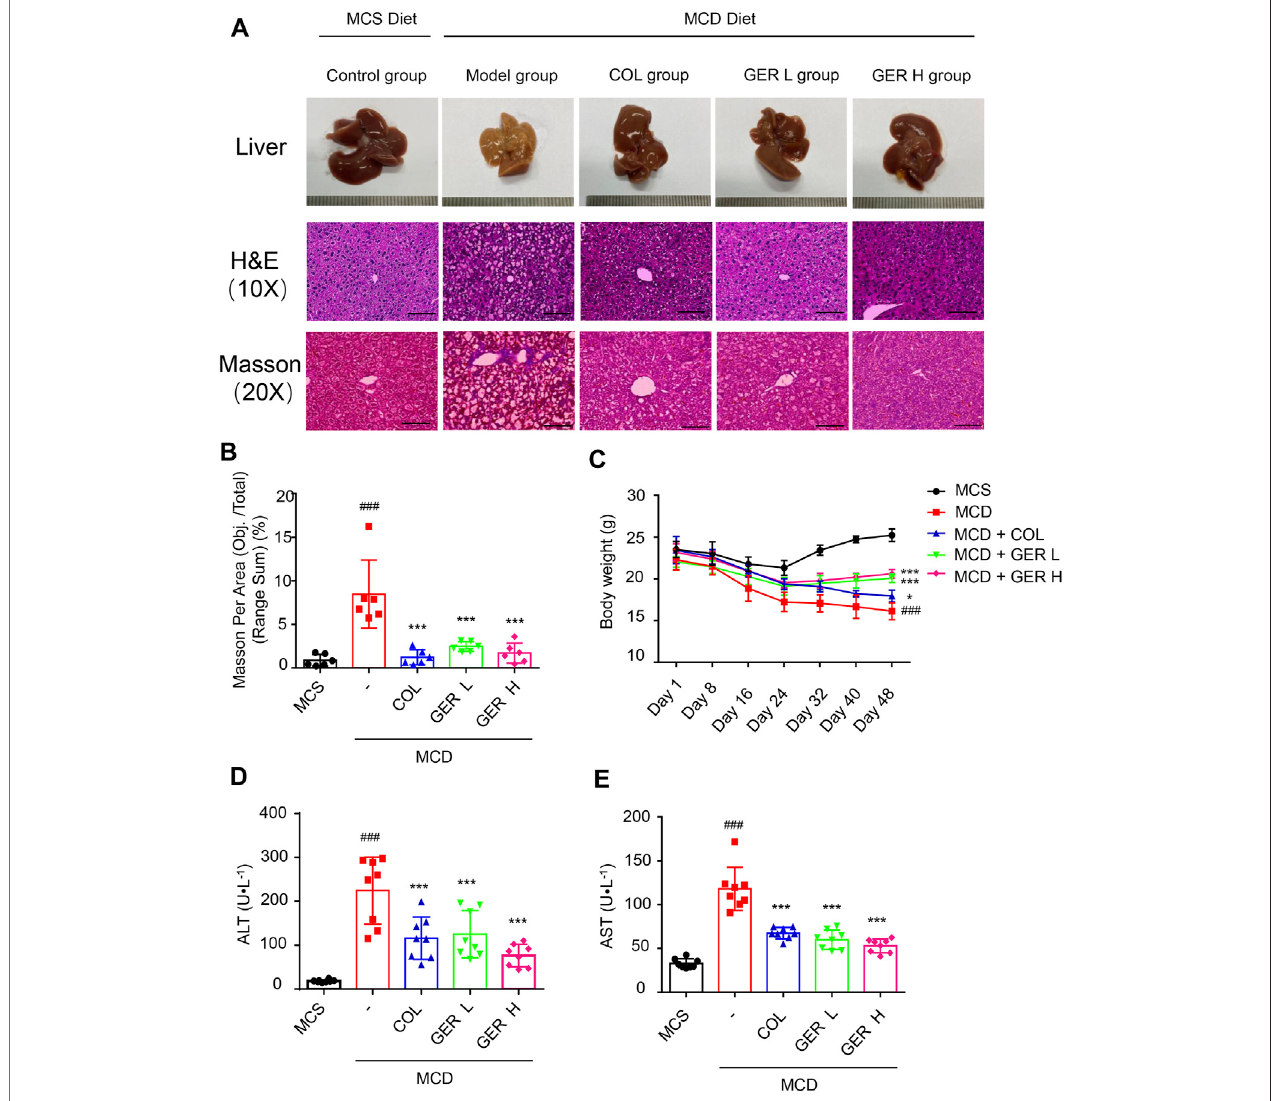
FIGURE 5 | GER ameliorates MCD diet-induced liver tissue and function damage. (A) Representative images of the liver and representative images of the liver sections stainedwithhaematoxylinandeosin(H&E, scalebars,50 μ m) andmasson(scalebars,100 μ m).Colchicine(COL)wasusedaspositivecontrol,GERL:thelow dose (25 mg/kg) of GER group, GER H: the high dose (50 mg/kg) of GER group. (B) Quanti fi cation of masson changes in different treatment groups ( n (cid:2) 6). (C) The weight changes of mice in different group for per 7 days (D,E) Serum alanine transaminase (ALT) and aspartate transaminase (AST) levels ( n (cid:2) 8). All data are presented as means ± SEM. ### p < 0.001 vs. the MCS group. *** p < 0.001 vs. the model group.